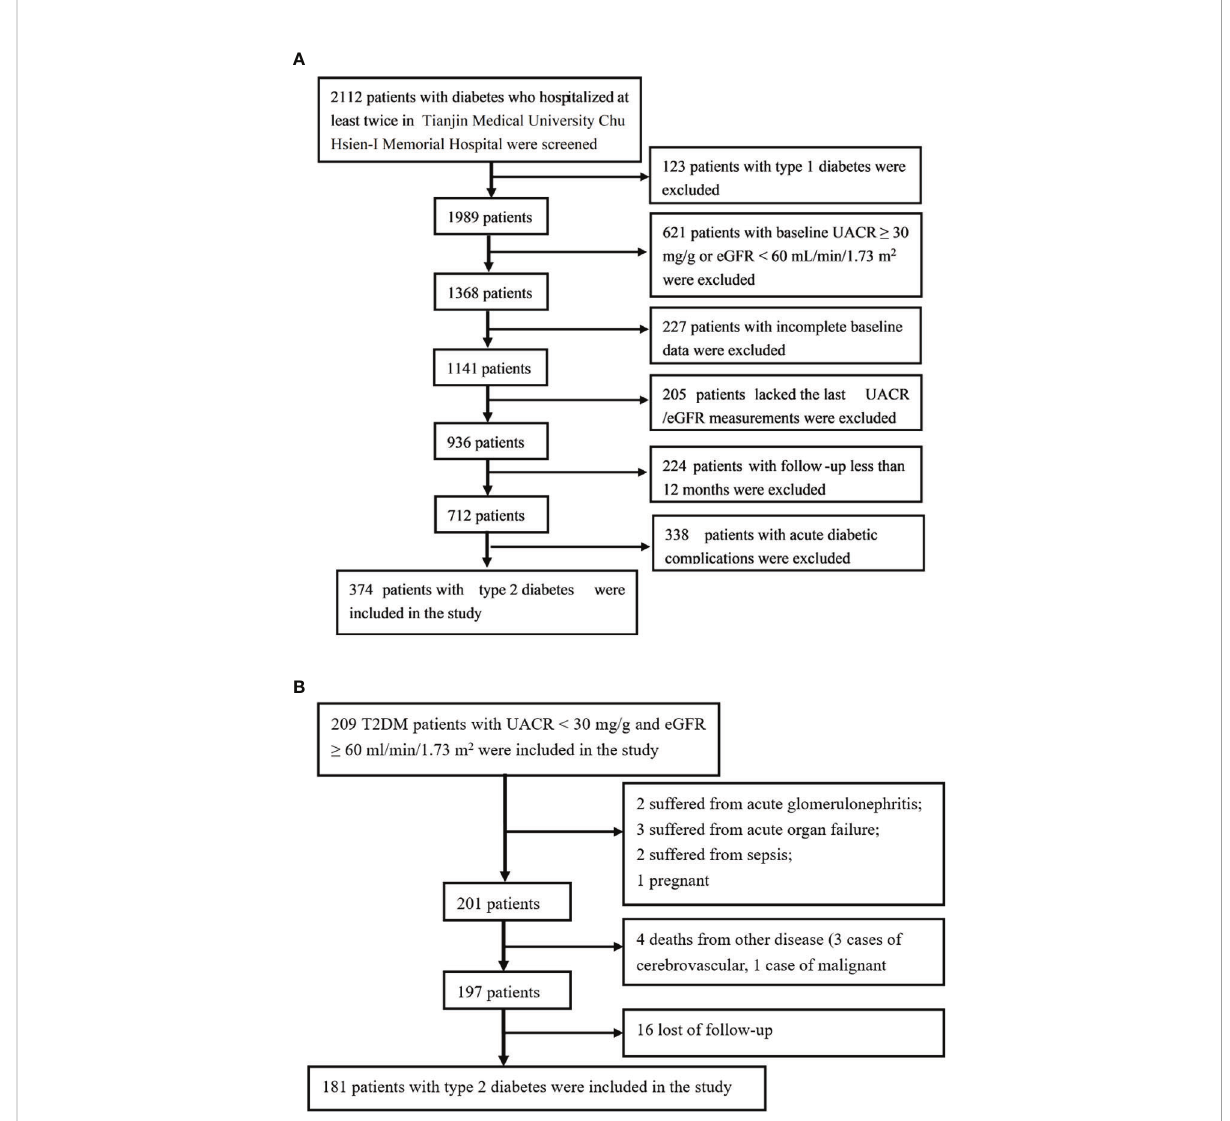
FIGURE 1 The fl owcharts outlining selection of cohorts. (A) The fl owchart outlining selection of the development cohort. (B) The fl owchart outlining selection of the validation